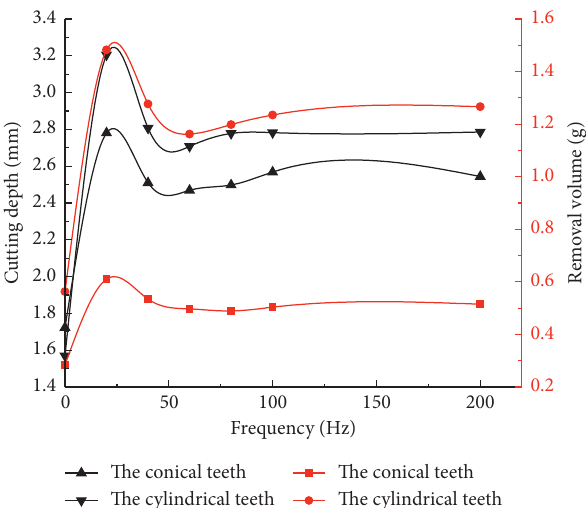
Figure 7: Cutting depth and removal volume.